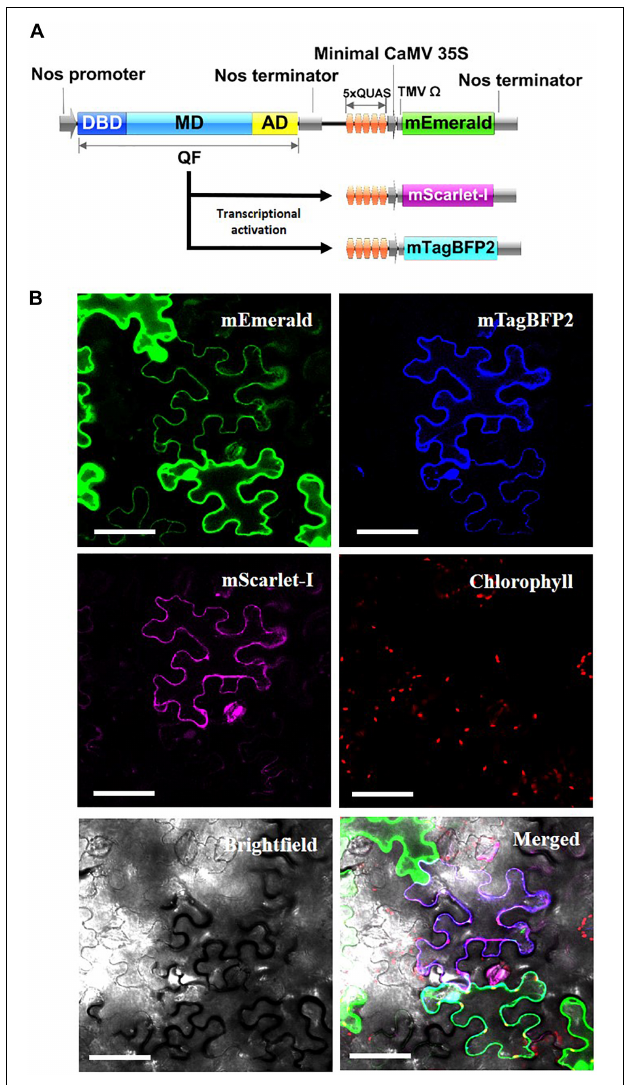
FIGURE 5 | Simultaneous activation of multiple reporter genes using a single QF transcription factor. (A) Schematic of N. benthamiana transient expression assay where QF is only expressed on the Nos:QF:5xQUAS:mEmerald construct. All three constructs (5xQUAS:mTagBFP2, 5xQUAS:mScarlet-I, and Nos:QF:5xQUAS:mEmerald) were co-transformed to determine simultaneous activation of three distinct fluorescent proteins. Experiments were performed in triplicate ( n = 3). (B) Confocal micrographs showing expression of three distinct fluorescent proteins controlled by the expression of QF on only a single construct. The intensity of mEmerald was decreased in cells expressing multiple fluorescent protein. Further, using this experimental design, cells could not express either mScarlet-I or mTagBFP2 unless the mEmerald construct was present. Chlorophyll autofluorescence was used as a control to set the initial laser threshold. Scale bar: 50 µ